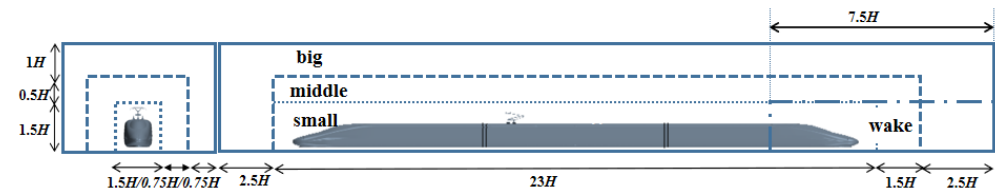
Figure 5. The distribution of refinement zone. Table 1. The mesh size of the refinement zone.